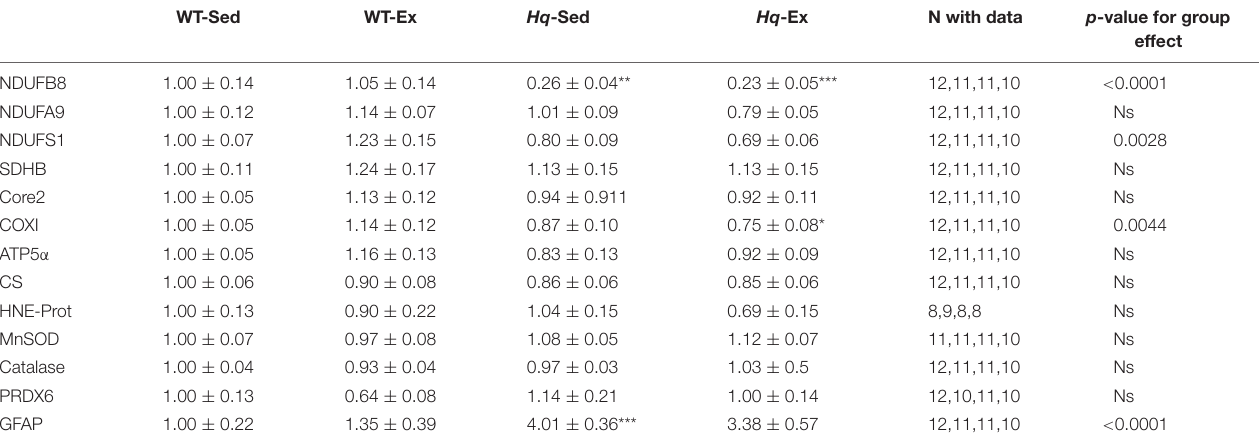
TABLE 1 | Brain variables.